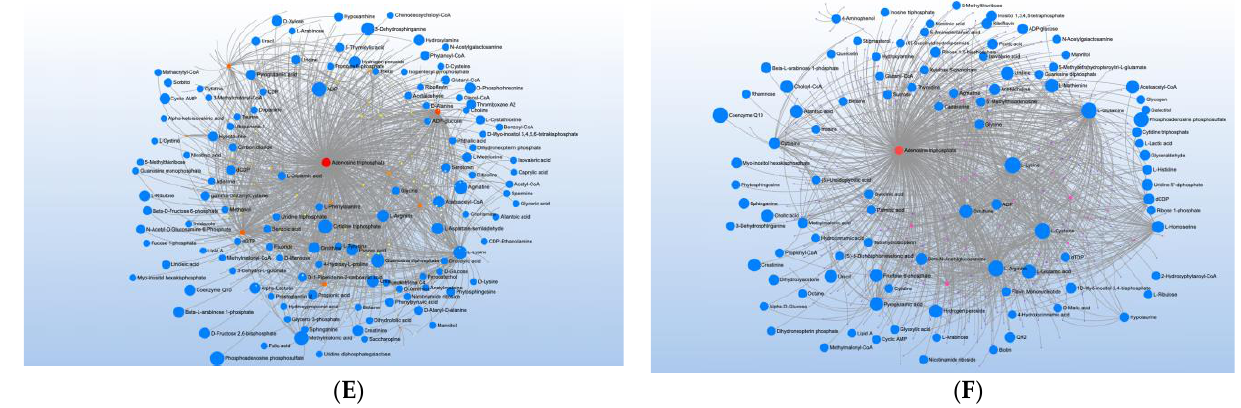
Figure 5. Metabolite–Metabolite Interaction Networks for Energy and Amino Acid Pathways in ASD ( A , B ), epilepsy (EPI) ( C , D ) and DD ( E , F )